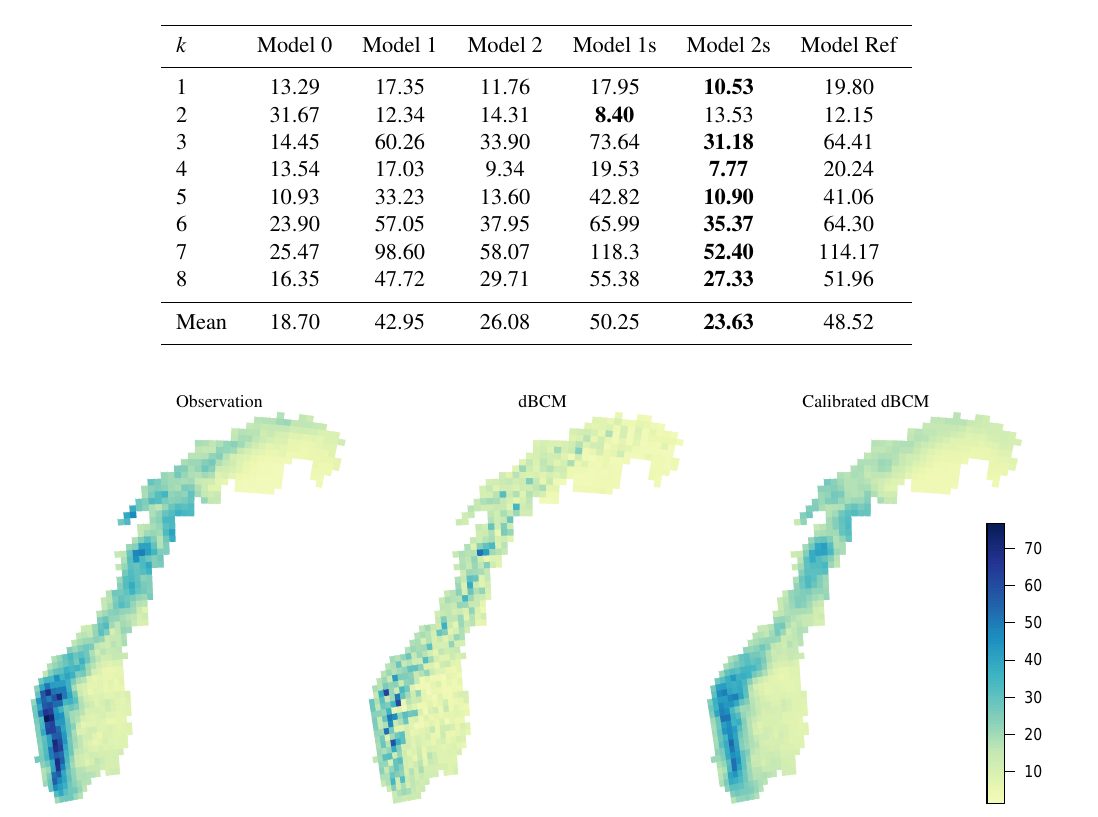
Table 2. Cross-validation mean square error for the 95% quantile using dBCM predictions. The best model (excluding Model 0) for each fold is displayed in bold. For this comparison, Model 0 can be seen as the target value we want to reach with the dBCM-based predictions.